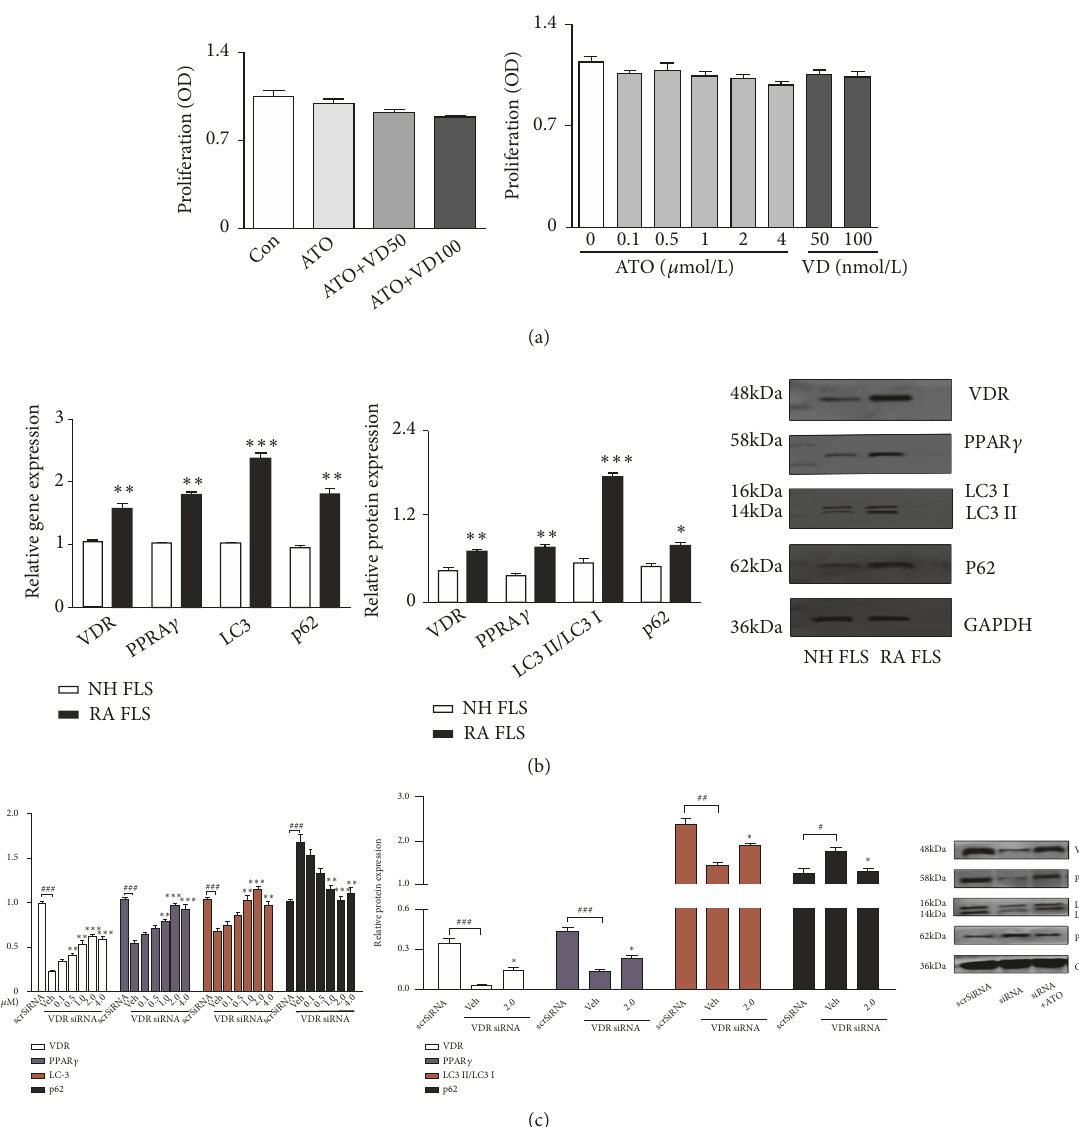
Figure 1: (a) After treatment with different concentrations of arsenic trioxide (ATO) (0.1, 0.5, 1.0, 2.0, or 4.0 𝜇 M) or Vitamin D (Vit D) (50 or 100nM) for 48 h ( n =3), CCK-8 was added to rheumatoid arthritis (RA) fibroblast-like synoviocytes (FLS) and incubated for 1 h. Absorbance (optical density value)at 450nm was detectedby a microplatereader. Theresults showed no significant influenceon cell proliferation after the administration of different concentrations of ATO and Vit D. The results are presented as the mean ± SEM. (b) Real-time PCR and western blot analysis showed significantly increased expression of the Vitamin D receptor (VDR), PPAR- 𝛾 , LC-3, and p62 in RA FLS ( n =3) compared with normal human (NH) FLS ( n =3; ∗ p < 0.05, ∗∗ p < 0.01, ∗∗ ∗ p < 0.001). The results are presented as means ± SEM. (c) Silencing of VDR in RA FLS significantly reduced the expression of VDR, PPAR- 𝛾 , and LC-3 but induced the expression of p62. Addition of ATO could reversethe effect of small interfering RNA (siRNA) ( n =3, # p < 0.05 ## p < 0.01 ### p < 0.001 versus scrambled siRNA-treated cells (SCR-siRNA); ∗ p < 0.05;